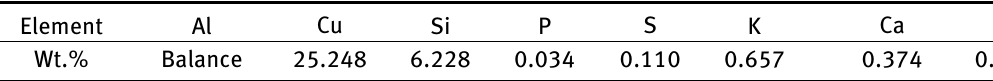
Table 2: Results of E , σ y , V θ %, HV , CTE and Wr Layers